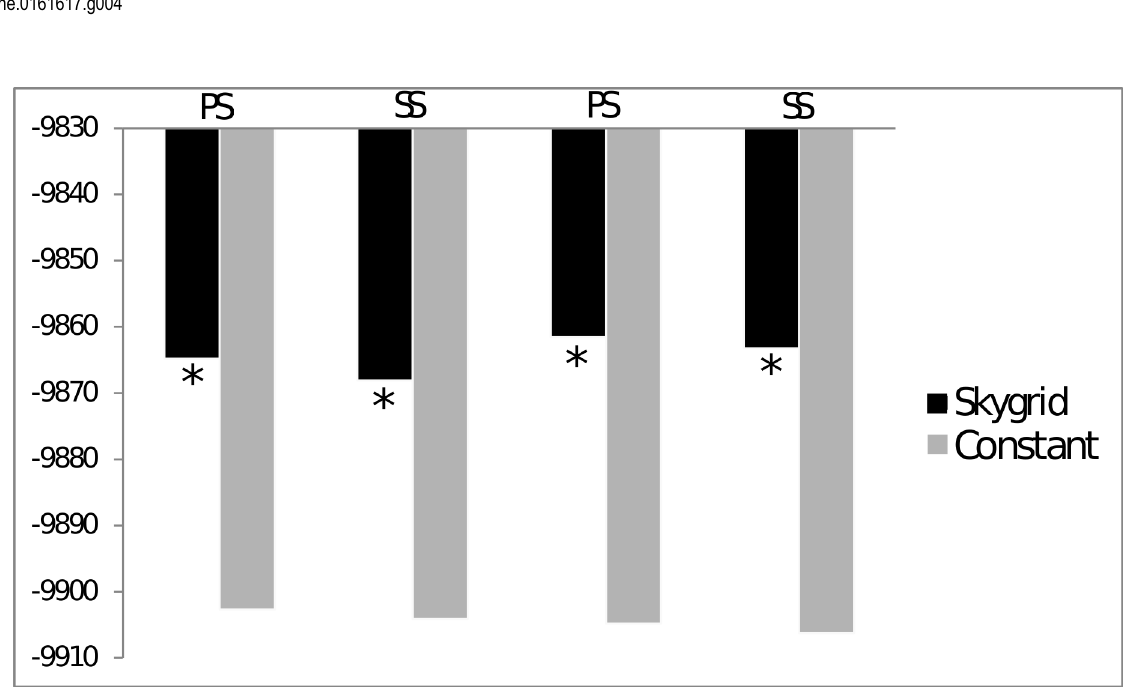
Fig 5. Estimates of the marginal probability values inferred by Path Sampling (PS) and Stepping-Stone (SS) Sampling. Values on the y-axis represent the marginal probability (in ln). Asterisks indicate strong evidence (i.e., Bayes Factor > 10) favoring one of the scenarios: Skygrid or stable